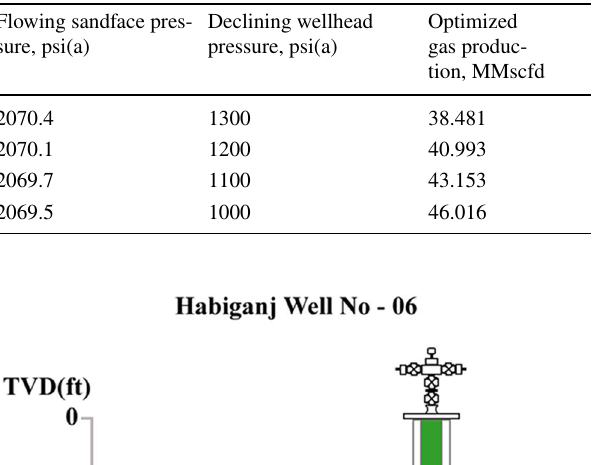
Table 4 Optimized gas production in different pressure conditions derived from the comparison of the reservoir model and Rawlins– Schellhardt ( P 2 ) model Flowing sandface pres- sure, psi(a)